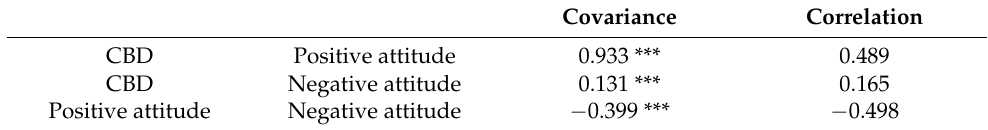
Table 5. Covariance and correlation of CBD construct and positive and negative attitude.